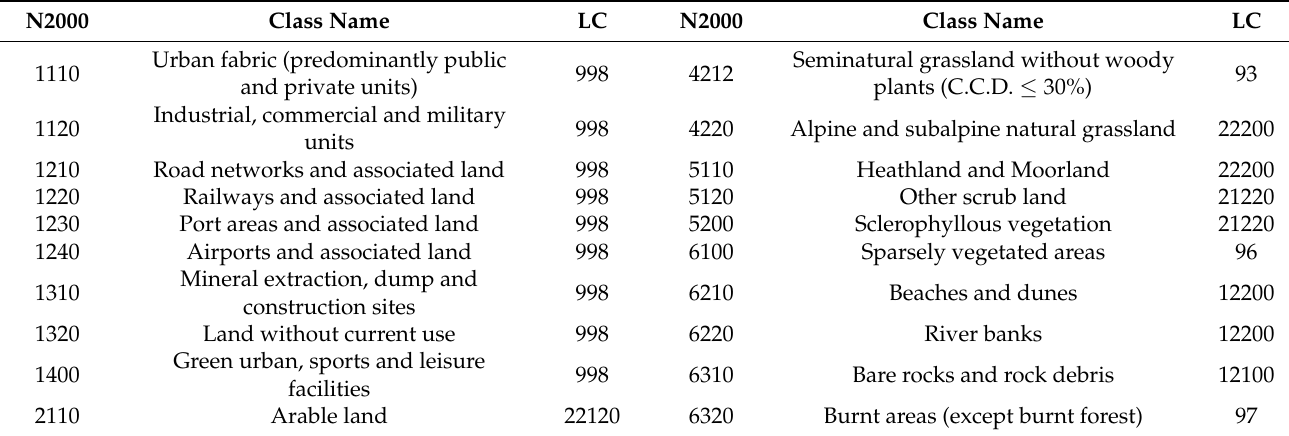
Table A1. Reclassification table for